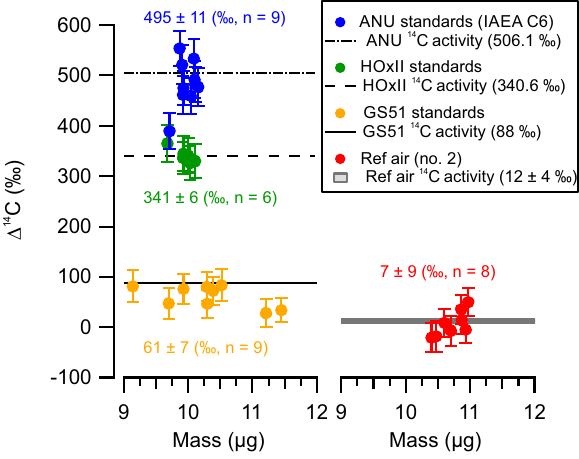
Figure 4. A summary of the derived 14 C activities (in (cid:49) 14 C,‰) of the reference materials and CO 2 extracted from reference air (no. 2) relative to HOxII. All the reference samples were prepared follow- ing identical preparation